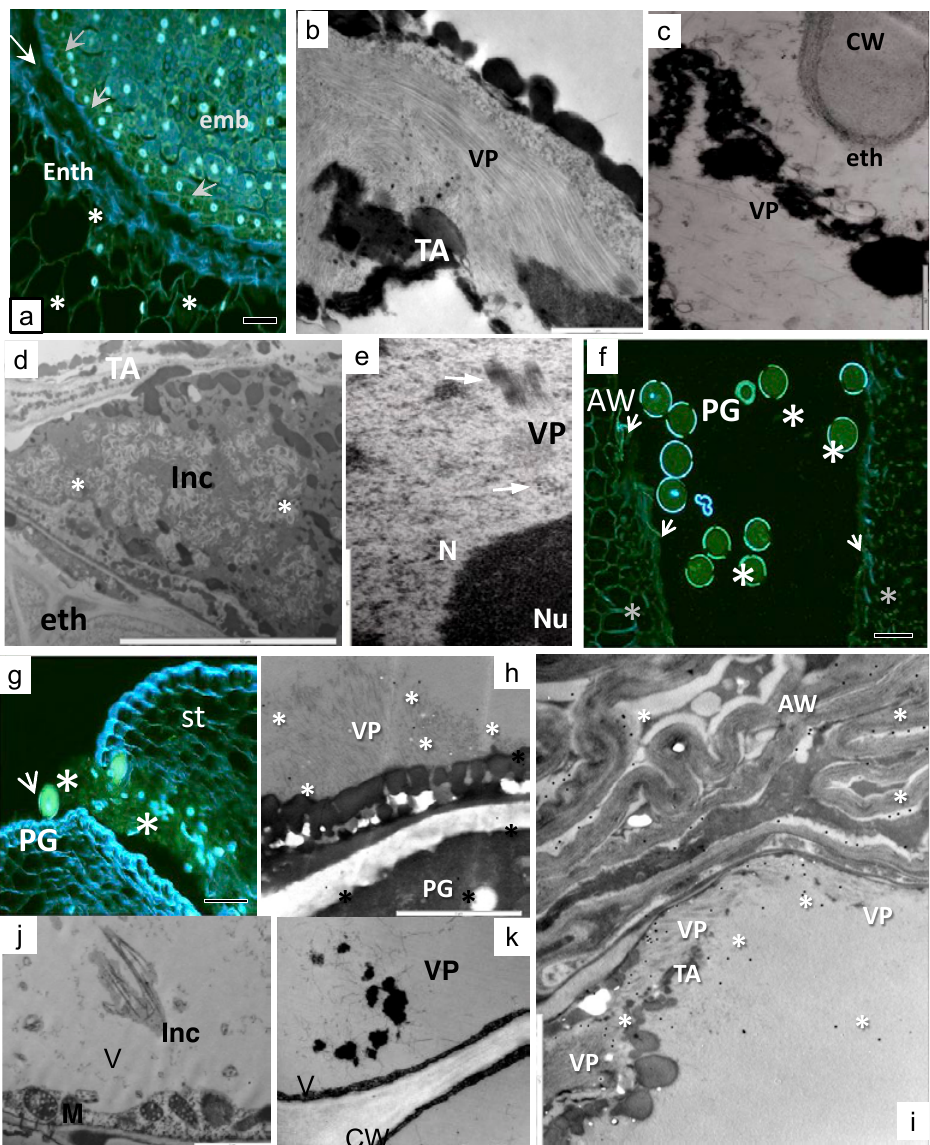
Figure 2. Examination of C. annuum seed embryos (a), anthers with pollen grains, (b-i) and next generation vegetative tis- sues (j-k). Immunolocalization of PVY NTN in C. annuum seeds (a) and anthers (f-i). a) Green fluorescence of PVY NTN epitope in degraded endothelium cell (white arrow, Enth), seed coat parenchyma cells (asterisk) and embryo (black arrow). Bar